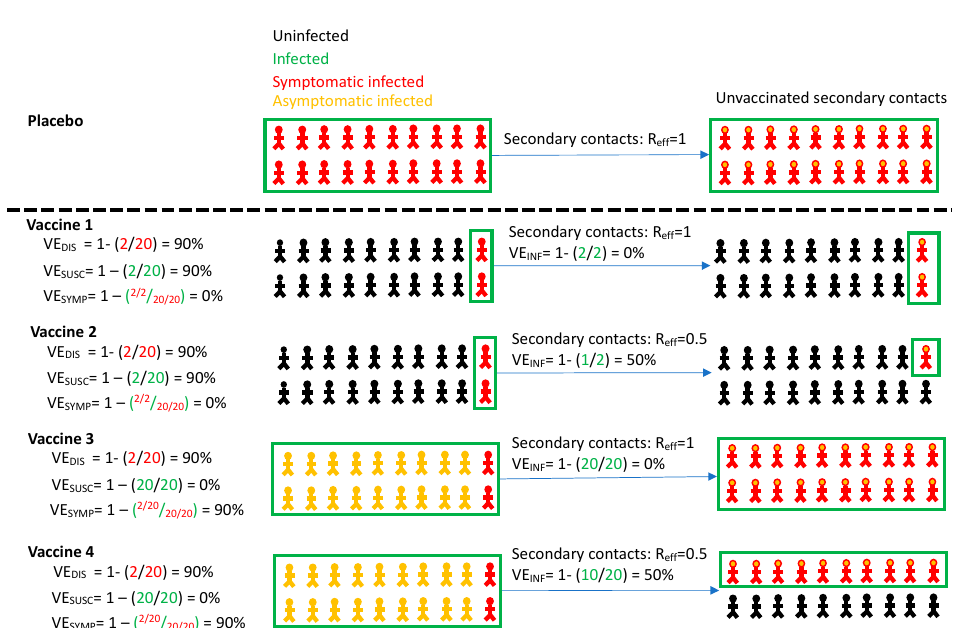
Figure 1. Vaccine efficacy definitions. Four vaccines with high efficacy against disease (VE DIS = 90%) are demonstrated with different projected outcomes on vaccinated persons ( left ) and secondary contacts of infected person ( right ). Vaccines 1 and 2 mediate reduction of symptomatic infection by eliminating infection altogether, whereas vaccines 3 and 4 reduce symptoms among infected people. Vaccines 1 and 3 provide no reduction in secondary transmission risk. Vaccines 2 and 4 provide 50% reduction in secondary transmission risk. Definitions are in Table 1. All persons in the placebo arm are symptomatically infected for demonstration purposes only. Infected secondary contacts may be symptomatic or asymptomatic. Here, R eff is the effective reproductive number representing number of secondary transmissions per infected person which we assume to be 1 in the absence of a vaccine.